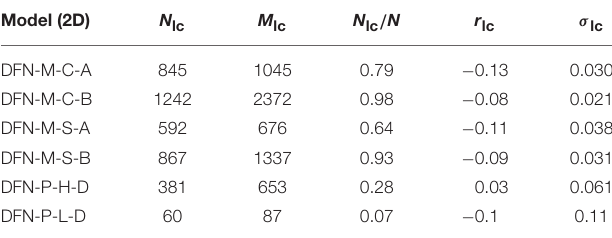
TABLE 4 | Average values for number of nodes N lc , links M lc , average ratio of nodes in the largest component and the entire graph N lc / N , as well as assortativity coefficient r lc with its standard deviation σ lc , for the largest component for 50 samples of each of the different limits of the two DFN models in two dimensions.